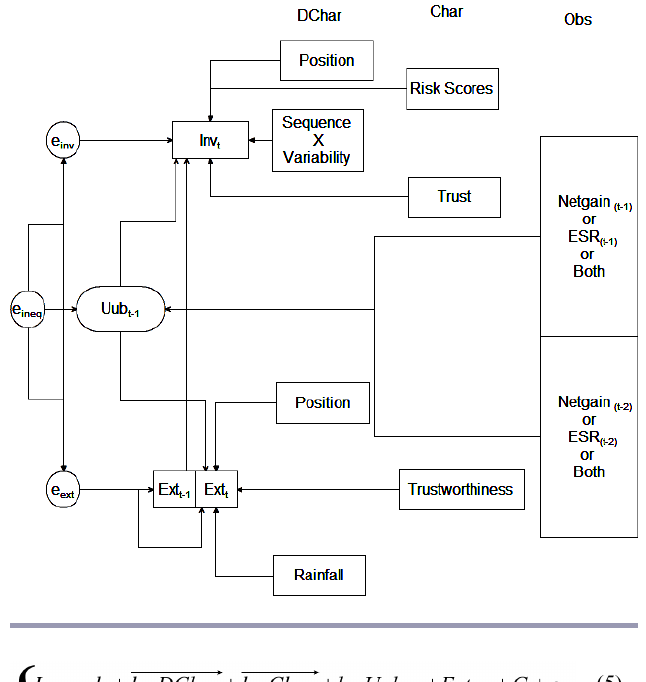
Fig. 7 . Diagrammatic representation of the statistical model represented in equation 5. Arrows represent the direction of dependencies as modeled. Arrows on the error terms indicate correction for autocorrelation and correlation between